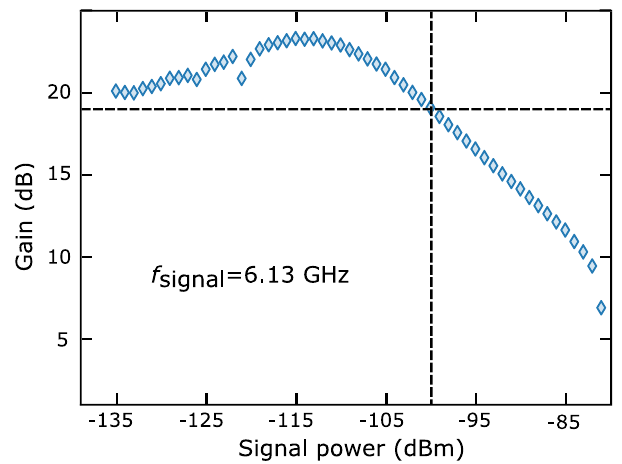
FIG. 17. Gain compression. Measured gain as a function of the ¼ 6 . 13 GHz. The gain is compressed by signal power for f signal 1 dB when the input signal power is equal to − 100 dBm.